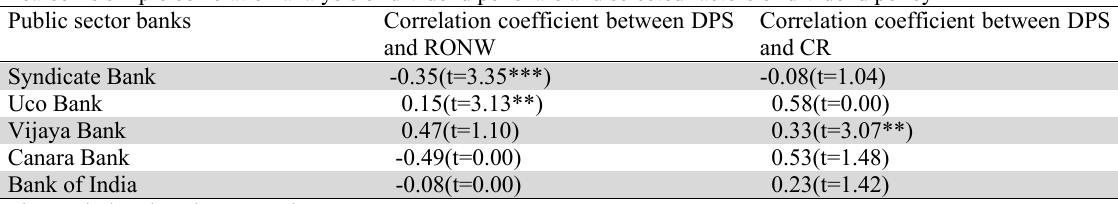
Pearson’s simple correlation analysis of dividend per share and selected factors of dividend policy